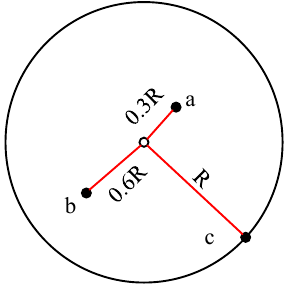
Figure 1. Hop count between the nodes connected by the three red lines is one hop, but the actual distance between them is quite different.